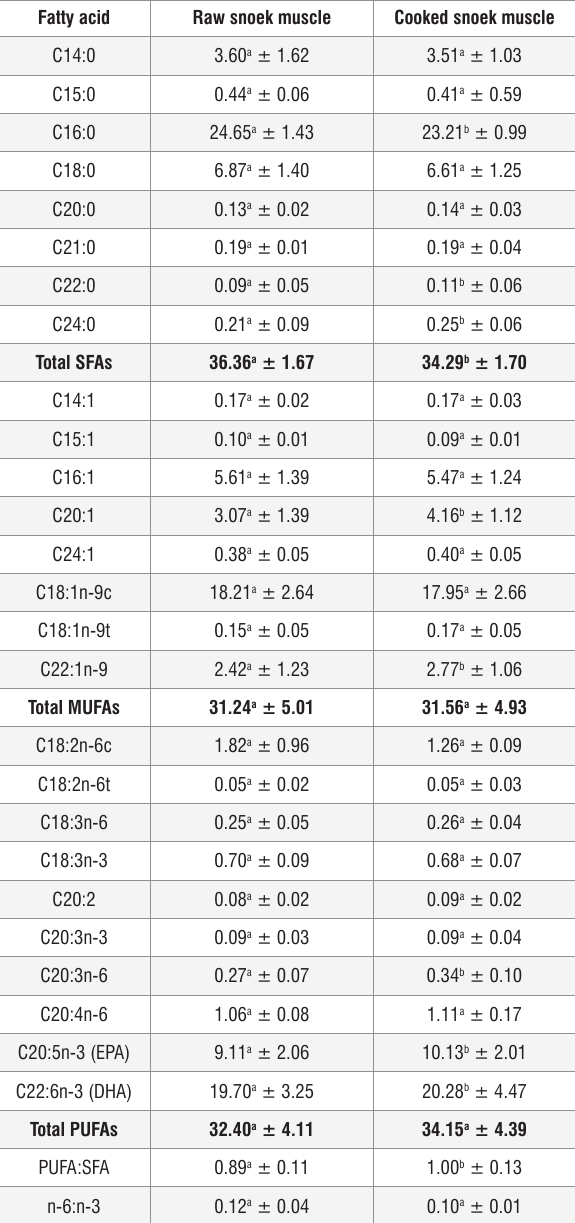
Fatty acid composition (% mean ± standard deviation) of raw and cooked † Cape snoek ( Thyrsites atun )